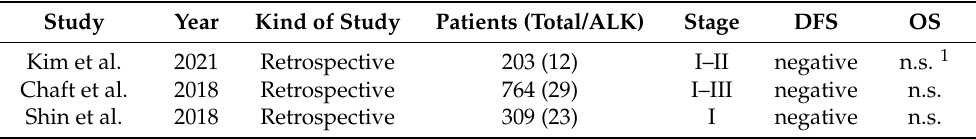
Table 2. Disease-free survival (DFS) and overall Survival (OS) in early-stage NSCLC with ALK